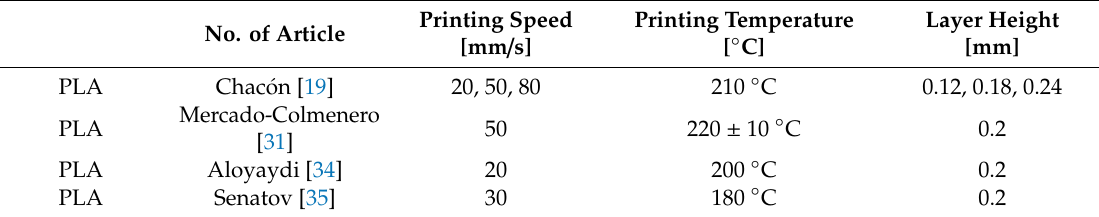
An overview of printing speeds, printing temperatures, and layer heights used in di ff erent